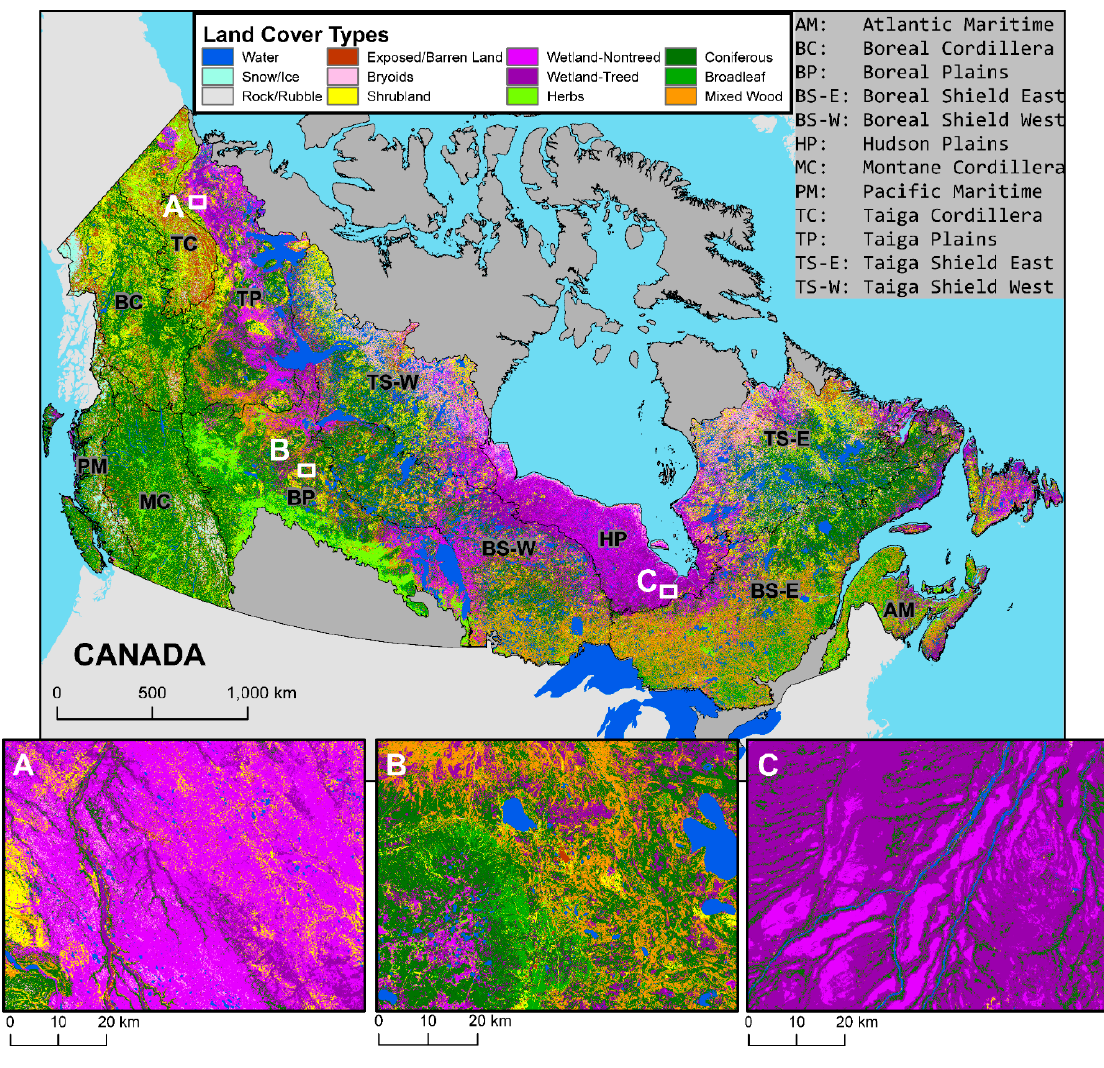
Figure 1. Land cover types within forest-dominated ecozones of Canada. The map was generated using the Virtual Land Cover Engine (VLCE) approach and validated for 2005 conditions (Hermosilla et al., 2018). Selected examples represent a landscape dominated by non-treed wetlands ( A ); a landscape mosaic of upland forest and wetlands ( B ); and a landscape complex of treed and non-treed wetlands ( C ).